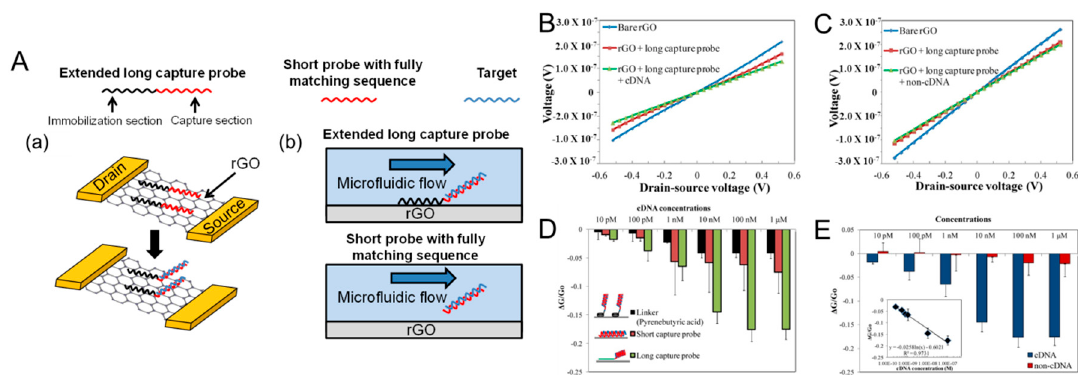
Figure 3. ( A ) Mechanism of extended long-capture probe immobilization strategy to keep probe stability in the flow environment. ( a ) The immobilization section of extended long-capture